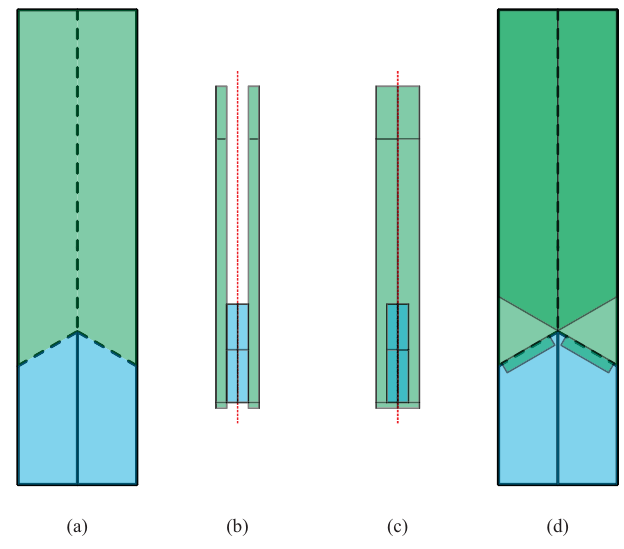
Figure 16. The schematic of the reverse fold pattern used in the de- sign of the lift. The dotted red line represents the joint plane. (a) The fold pattern. (b) A side view of the panel stack. (c) The panel stack with offsets which in this design are large and cover the majority of the inside face of each green panel. (d) The open pattern with the